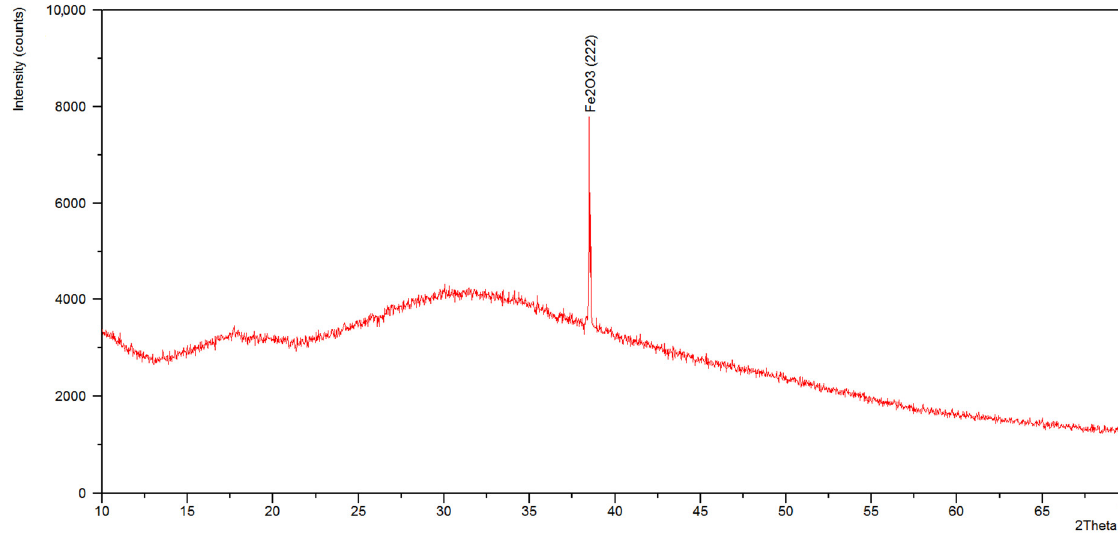
Figure 8. X-ray diffraction patterns of the leachate.